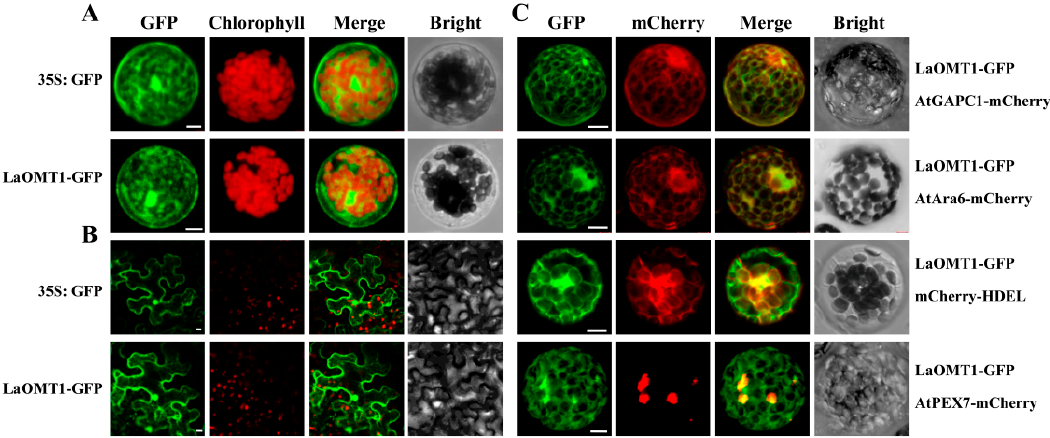
Figure 6. Subcellular localization of LaOMT1. ( A ) Subcellular localization of GFP alone and LaOMT1-GFP fusion protein in Arabidopsis protoplasts. ( B ) Subcellular localization of GFP alone and LaOMT1-GFP fusion protein in tobacco epidermal cells. ( C ) Protoplasts co-expressing LaOMT1-GFP and four different Arabidopsis marker proteins, i.e., a cytoplasm marker (AtGAPC1-mcherry), an endosome marker (AtAra6-mcherry), an endoplasmic reticulum (mcherry-HDEL) and a peroxisome marker (AtPEX7-mcherry), respectively. The photographs were taken in the green channel (GFP fluorescence), red channel (mCherry fluorescence), combination of green and red channel, and bright channel. Scale bar = 10 μ m.